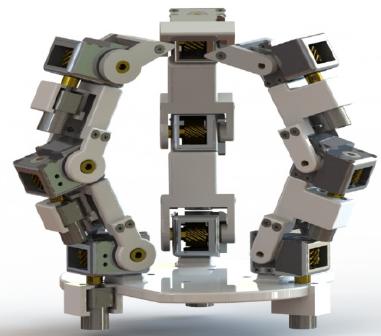
Figure 6. Assembly diagram of tomato picking manipulator.